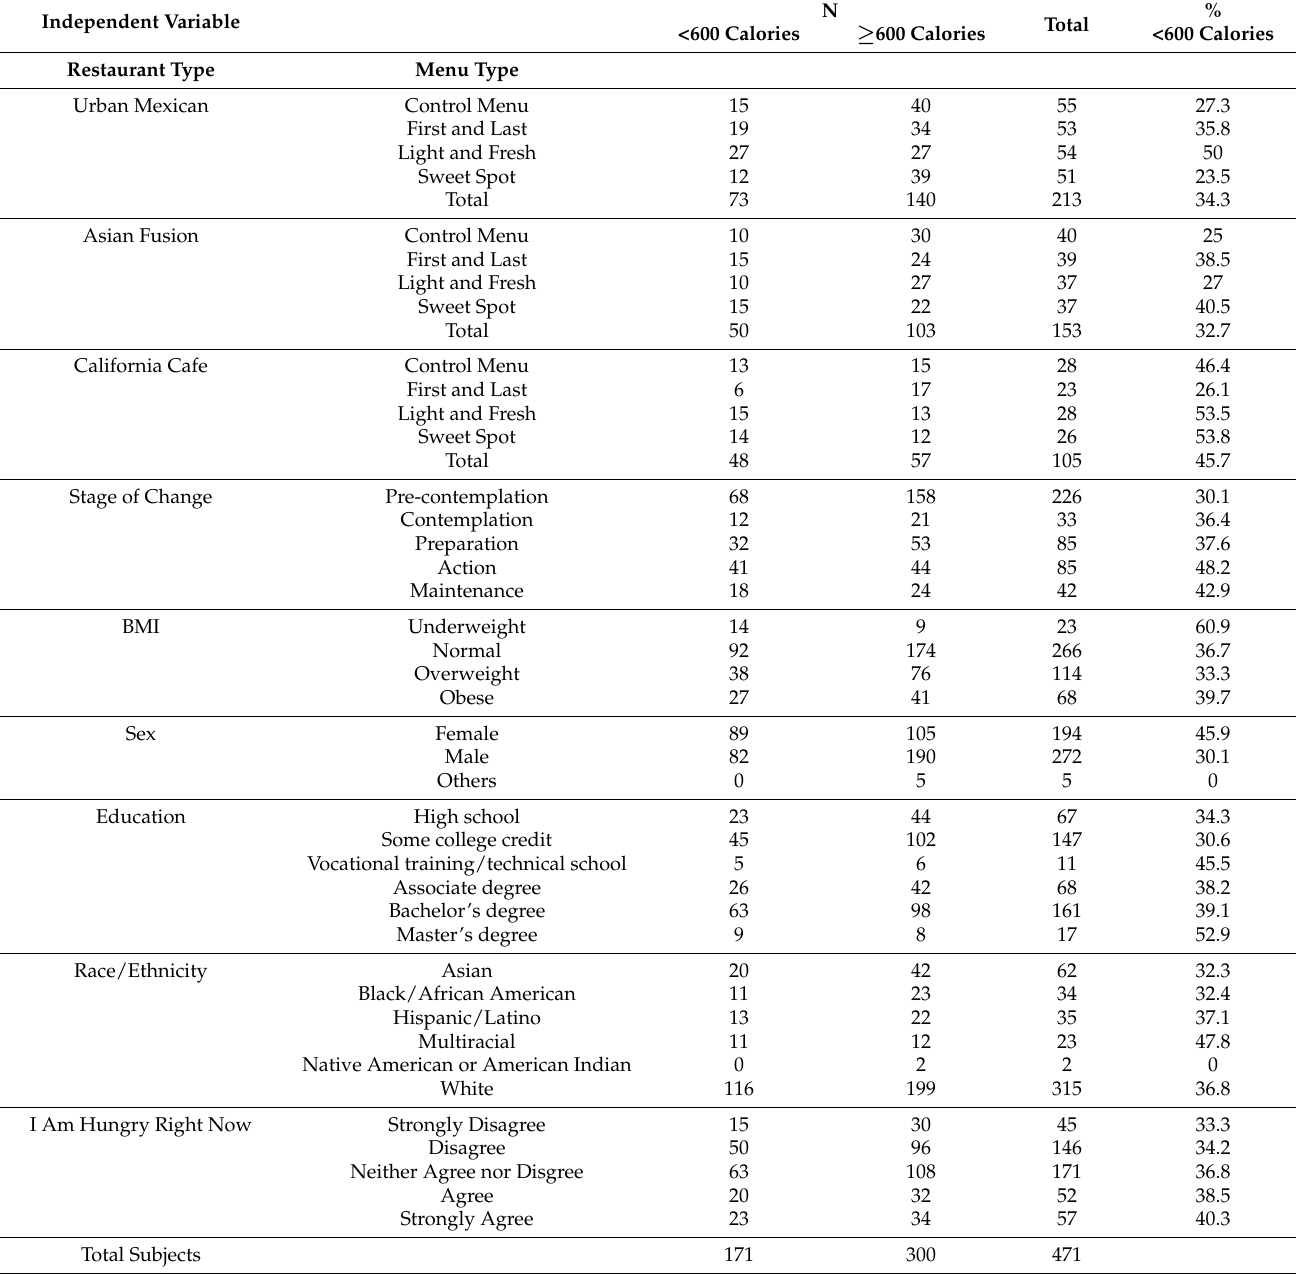
Table 4. Counts for subjects by the independent variables: restaurant type, menu type, stage of change, body mass index, sex, education, and race/ethnicity. Crosstabulations and percentages between the independent variables and the dependent variable menu entree calorie choice (<600 calories or ≥ 600